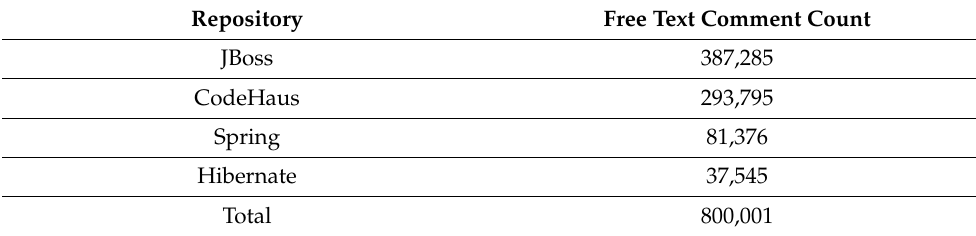
Table 6. A record count of the free-text comments being used to train the Siamese LSTM